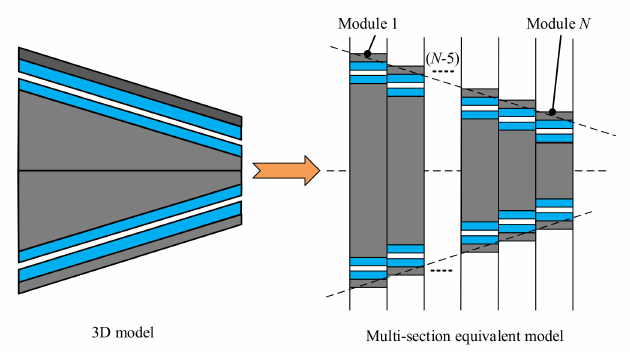
Figure 6. Equivalent 3D analysis model of